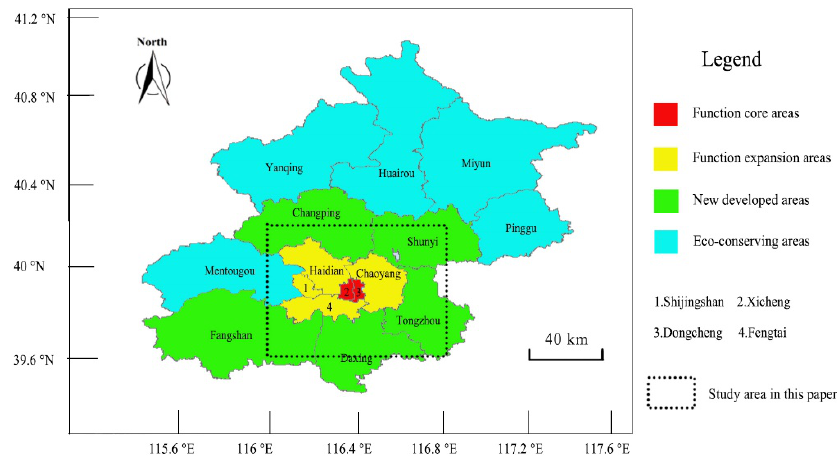
Figure 3. Map of Beijing, China, divided into districts according to administrative regions and functional areas.